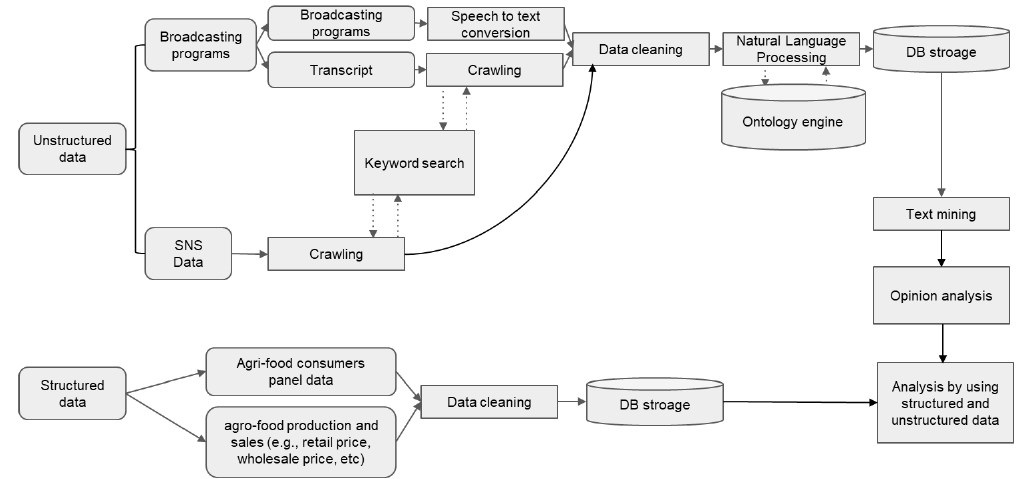
Figure 1. Agri-food related structured and unstructured bigdata modified from [2]. SNS for social network service, DB for